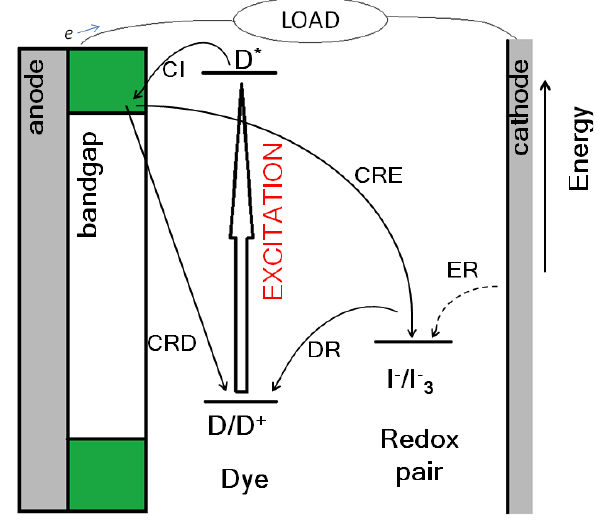
Figure 1. A typical photoelectrochemical cell, where dye molecules are adsorbed on a semiconductor (TiO ). Photons excite the dye from the ground (D/D + ) into an excited state 2 (D*). The excited electron is transferred into the TiO conduction band (CI: charge 2 injection) and the oxidized dye is regenerated by electrolyte species (DR: dye regeneration, ER: electrolyte regeneration). The cell’s current, voltage and the unwanted recombination (CRD/CRE: charge recombination to dye/electrolyte) can be controlled by functionalizing TiO with co-adsorbent 2